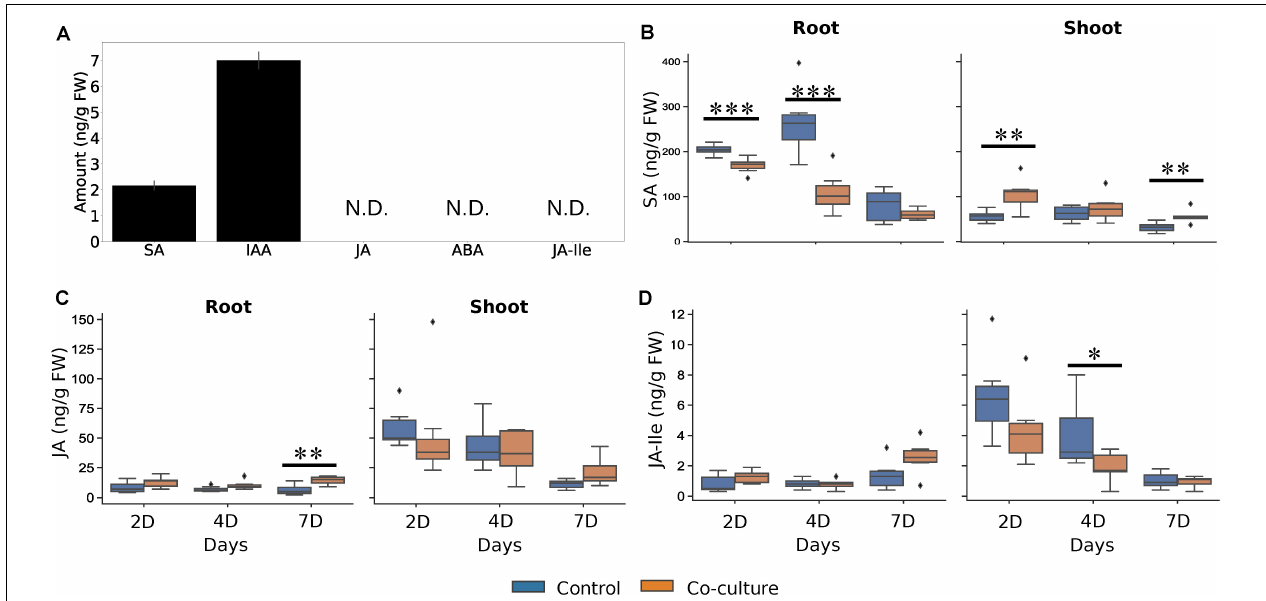
FIGURE 9 | Trichoderma facilitates the allocation of phytohormones in A. thaliana . (A) Phytohormone levels in Trichoderma mycelium. Error bars represent the SEs from six independent biological replicates. N.D., not detected. (B–D) SA (B) , JA (C) , and JA-Ile (D) levels from control and co-cultured seedlings in roots and shoots 2, 4, and 7 days after co-cultivation. Statistical significance was determined by Welch Two Sample t -test between control and co-culture treatments ( ∗ P < 0.05; ∗∗ P < 0.01; ∗∗∗ P < 0.001). At least 6 biological replicates were used for measurement, each with 16 seedlings. ABA, abscisic acid; IAA, indole-3-acetic acid; SA, salicylic acid; JA, jasmonic acid; JA-Ile, jasmonoyl-isoleucine conjugate. The diamond shape in the figure represent outliers, which the data points exceed 1.5 times of the inter-quartile range from the 75th percentiles, or lower than 1.5 times of the inter-quartile range from the 25th percentiles. The inter-quartile range is the range between 25th and 75th